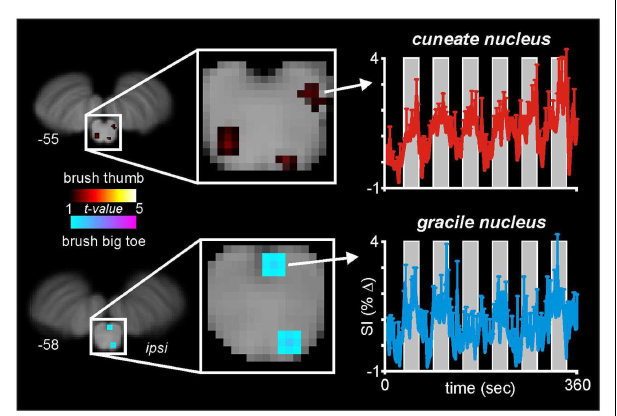
FIGURE 2 | Medullary activation during repeated innocuous brushing of the thumb and big toe in five subjects . Note that thumb brushing activates a region of the ipsilateral dorsal medulla that is lateral and marginally rostral to that region activated by brushing of the big toe.These activation patterns are consistent with the well-described termination patterns of non-noxious somatosensory afferent neurons, i.e., the cuneate and gracile nuclei. Note that during each of the six brushing period (vertical gray bars), the mean ( ± SEM) percentage change in signal intensity increases.The slice locations in Montreal Neurological Institute space are shown at the lower left of each section.